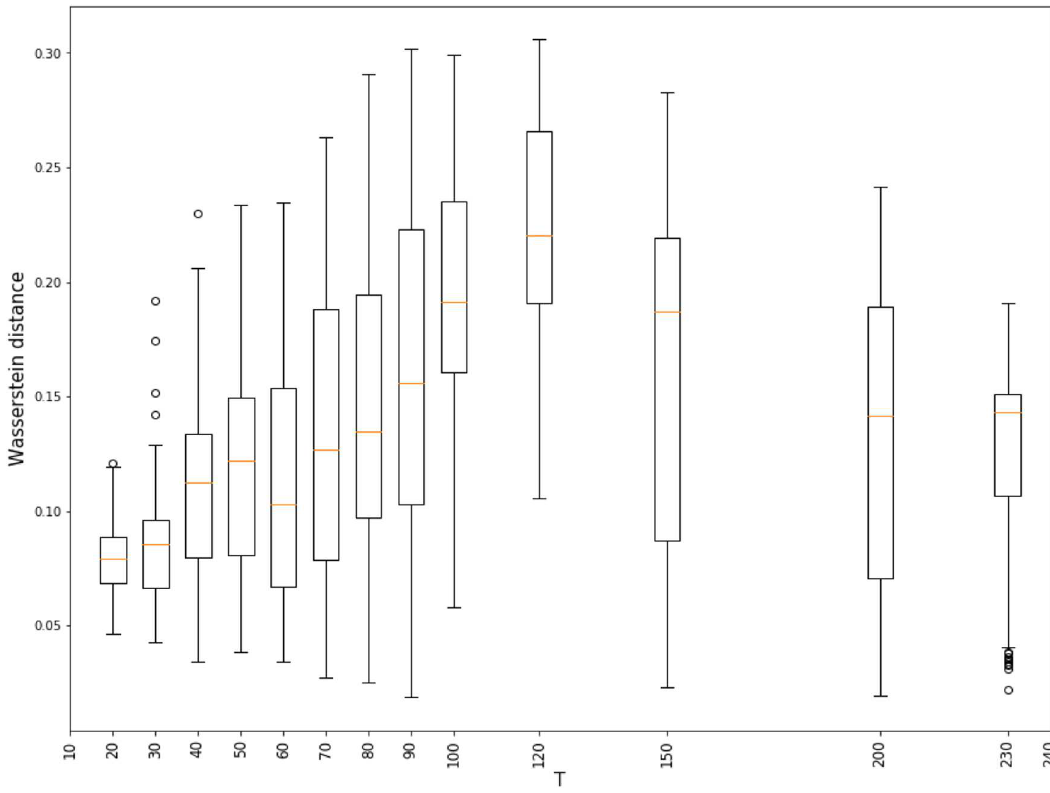
Fig. 10. Evolution of the EMD for 100 realizations of the 500 × 500 training image at (cid:15) = 12% with T varying in { 20 , 30 , . . . , 100 , 120 , 150 , 200 , 230 } and OL set to a third of T